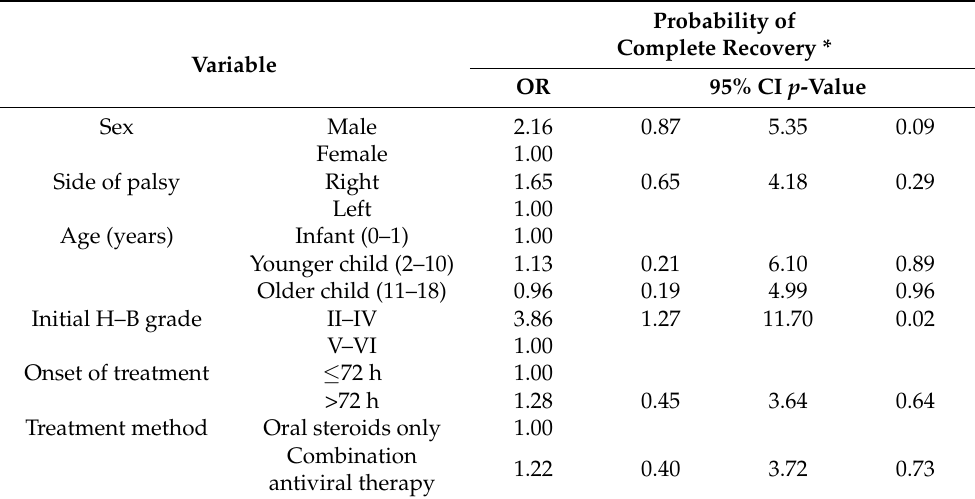
Table 3. The results of multiple logistic regression analysis of factors predicting complete recovery in children with Bell’s